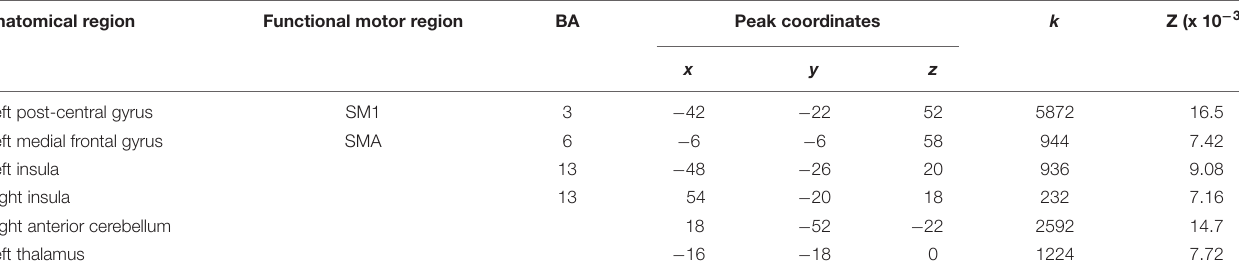
FIGURE 1 | Older and young adults likely recruit different brain areas. Whole-brain activation likelihood estimation (ALE) maps for (A) young adults, (B) older adults, and (C) conjunction of older and young adults (cluster-level inference corrected threshold at p < 0.05). All maps exhibited suprathreshold ALE values in left primary sensorimotor cortex (SM1), left supplementary motor area (SMA), bilateral insula, right anterior cerebellum, and left thalamus. In addition, older and young adult maps showed suprathreshold ALE values in regions of right SMA, dorsal premotor cortex, and left putamen. In the older adult map only, please note the suprathreshold ALE values in right SM1, extending into dorsal premotor cortex. L, left hemisphere; R, right hemisphere. Tables 3 and 4 provide the full list of ALE peaks for these maps. TABLE 4 | Activation likelihood estimation peaks from conjunction of young and older adult ALE maps. Anatomical region Functional motor